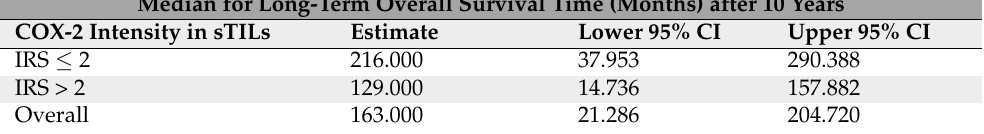
Table 1. There is a clear difference in long-term overall survival after 10 years for patients with intensity values for COX-2 expression in sTILs > 2. Patients with intensity values > 2 live with a median of 129 months, whereas patients with lower IRS values survive 216 months. As the table shows, the survival of patients of both groups differs by 87 months, i.e., more than 7 years. Even in the total group, a survival difference is recorded: patients live a total of 163 months, but still lose 34 months of life with higher intensity values. Median for Long-Term Overall Survival Time (Months) after 10 Years COX-2 Intensity in sTILs Estimate